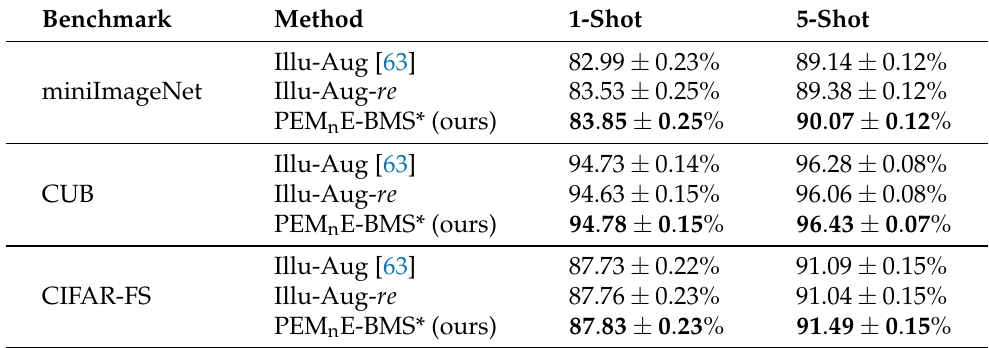
Table 7. The proposed method on backbones pre-trained with external data. Note that - re denotes the re-implementation of an existing method. Best results are in